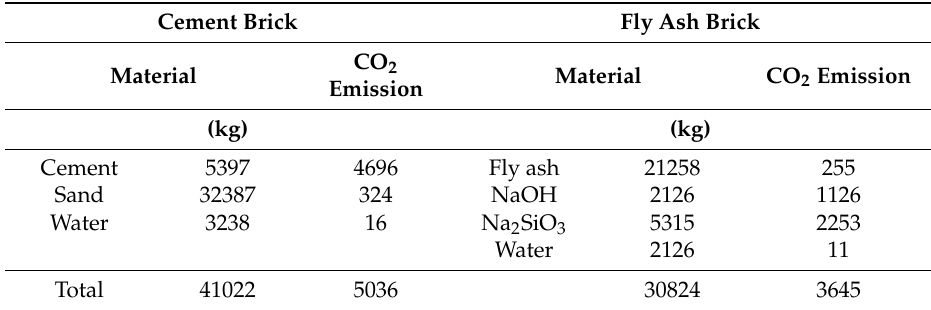
Table 6. Cement or fly ash materials required for the construction of a two-room structure per quantity of CO 2